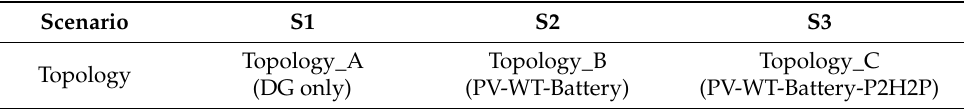
Table 2. Scenario